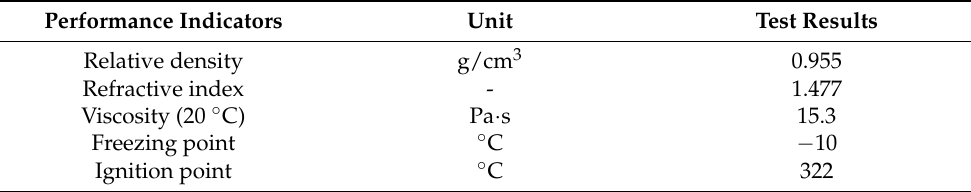
Table 2. Performance indicators of castor